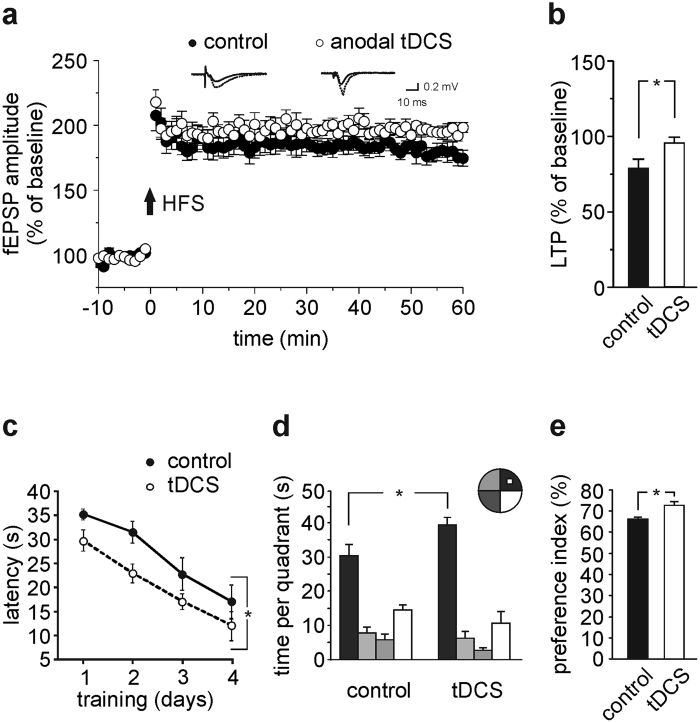
Anodal tDCS-induced enhancement of hippocampal plasticity persists 1 week after stimulation.(a) Time course and (b) magnitude of LTP induced by HFS protocol in hippocampal slices from mice sacrificed 1 week after tDCS (n = 11 slices from 6 mice) or sham stimulation (n = 9 slices from 5 mice); P = 0.02; unpaired Student’s t-test. (c,d) Results from MWM test started 1 week after stimulation (n = 9 controls and n = 7 tDCS-mice). (c) Escape latency to reach the hidden platform (main effect of days: F3,42 = 28.5, P < 0.001, two-way RM ANOVA). tDCS-mice exhibited reduced latency to reach the hidden platform compared to controls (F1,42 = 6.8, P = 0.021 for overall acquisition, two-way RM ANOVA). (d) Time spent in the four quadrants during probe test (P = 0.0064, two-way RM ANOVA, Bonferroni post-hoc). (e) Preference toward the novel object in NOR paradigm (n = 8 for each group; P = 0.004, unpaired Student’s t-test). Data are expressed as mean ± s.e.m. *P < 0.05.